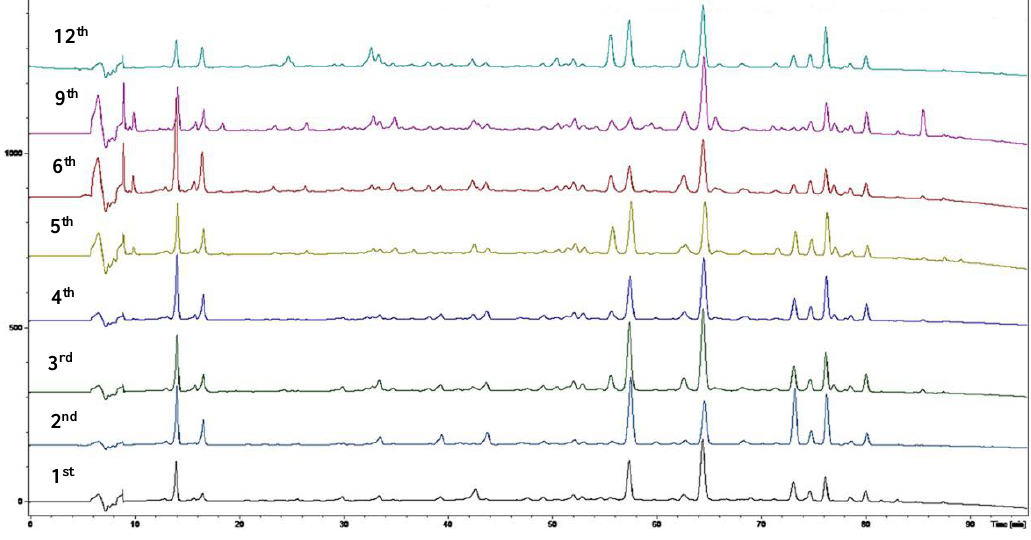
Figure 1. The UPLC spectrum of agarwood samples produced from the 1st to 12th months.